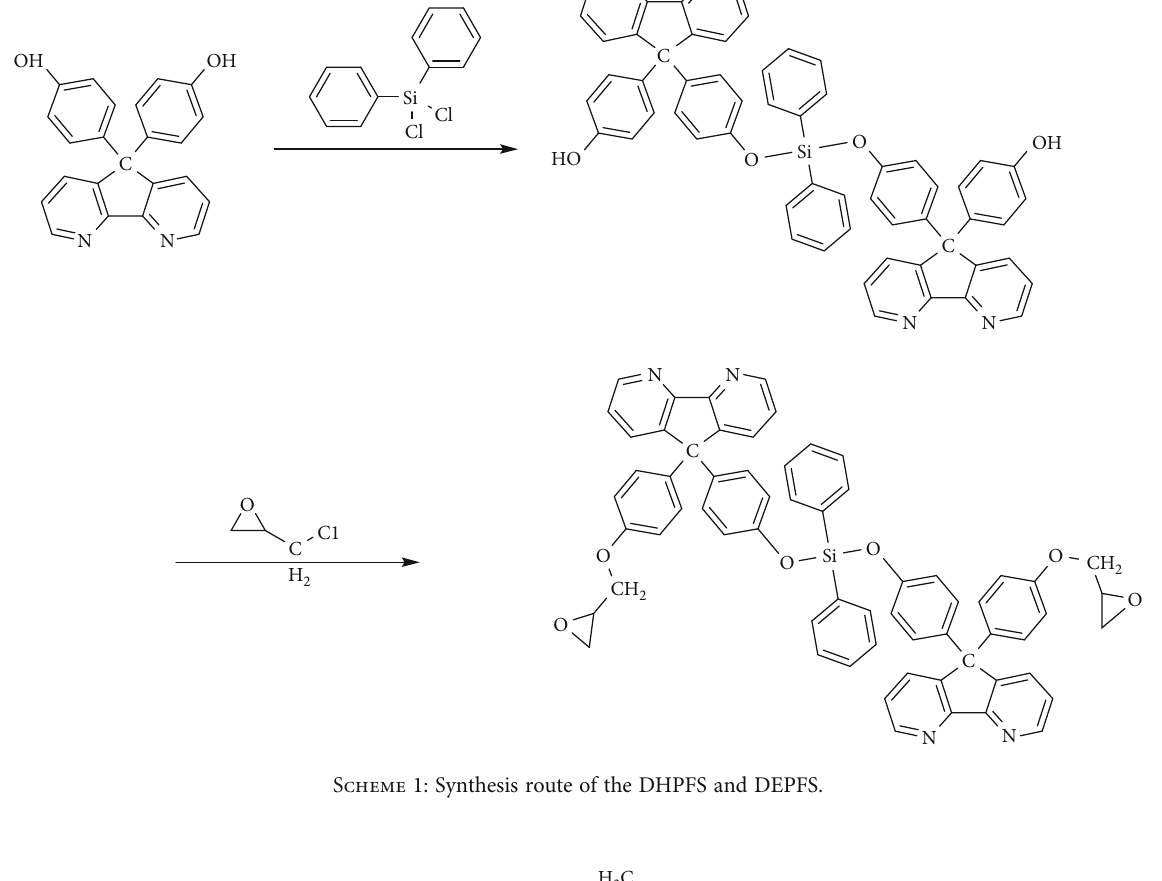
Scheme 1: Synthesis route of the DHPFS and DEPFS.